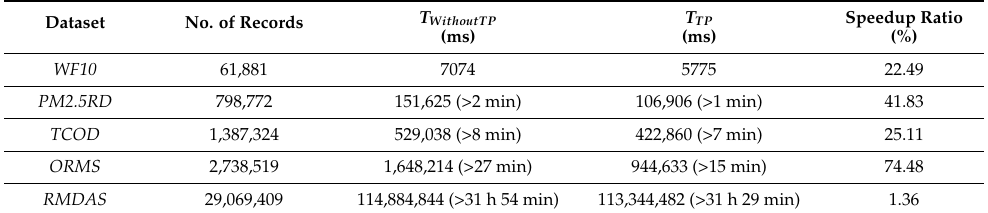
Table 3. Time of data ingestion from data servers with a bulk of HTTP GET requests in different ways.